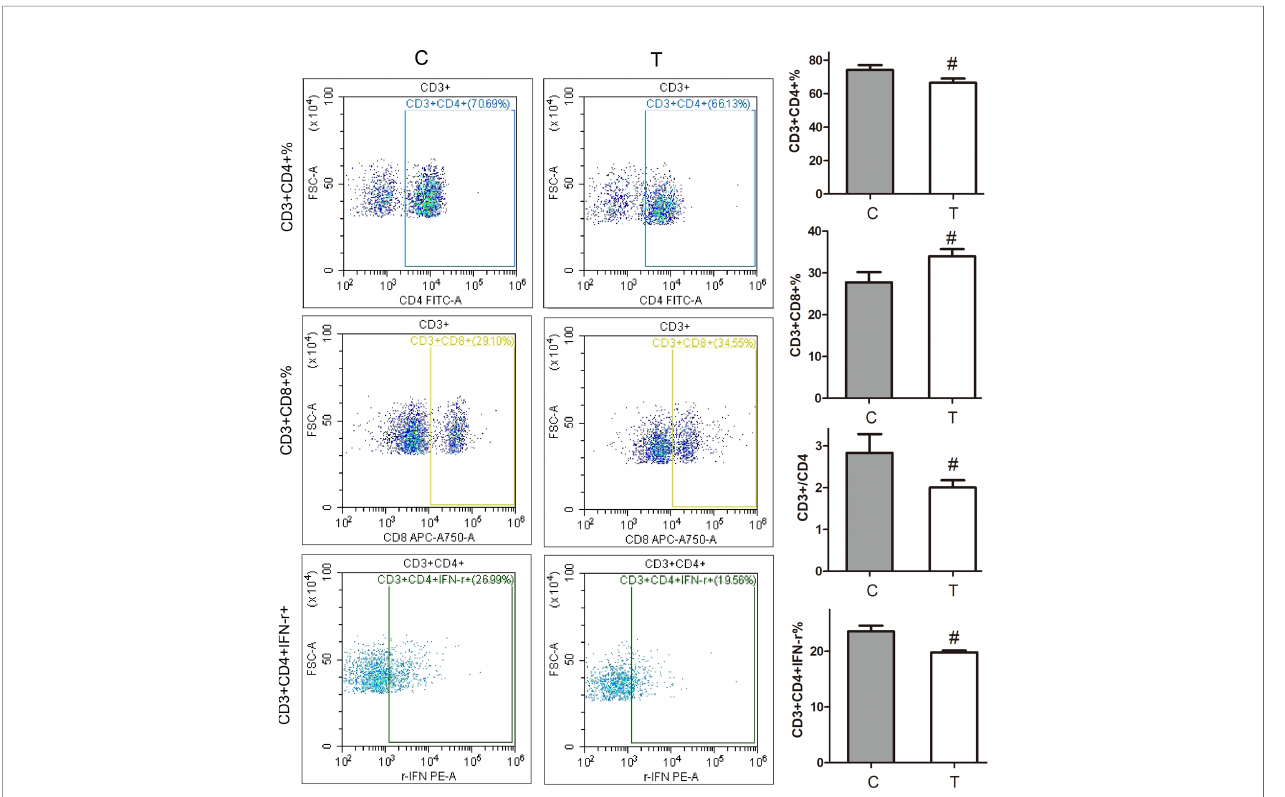
FIGURE 2 | Changes in subsets and function of lymphocytes. Compared with the normal control group, the percentage of CD3+CD4+ in thyrotoxicosis mice decreased signi fi cantly, while the percentage of CD3+CD8+ increased signi fi cantly, so the percentage of CD4+/CD8+ decreased signi fi cantly. The percentage of CD3 + CD4 + IFN-r + was signi fi cantly decreased in thyrotoxicosis mice. C, normal control group; T, thyrotoxicosis group. Compared with normal control mice #p <